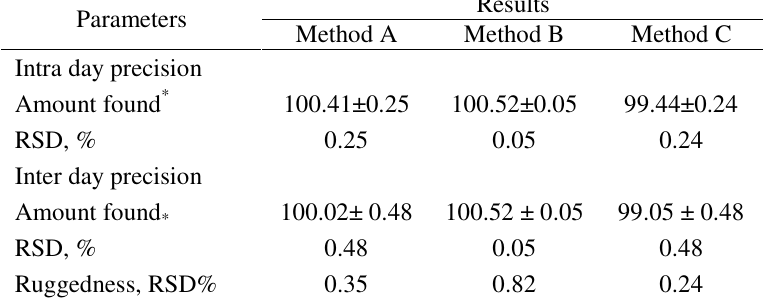
Table 3b. Summary of validation